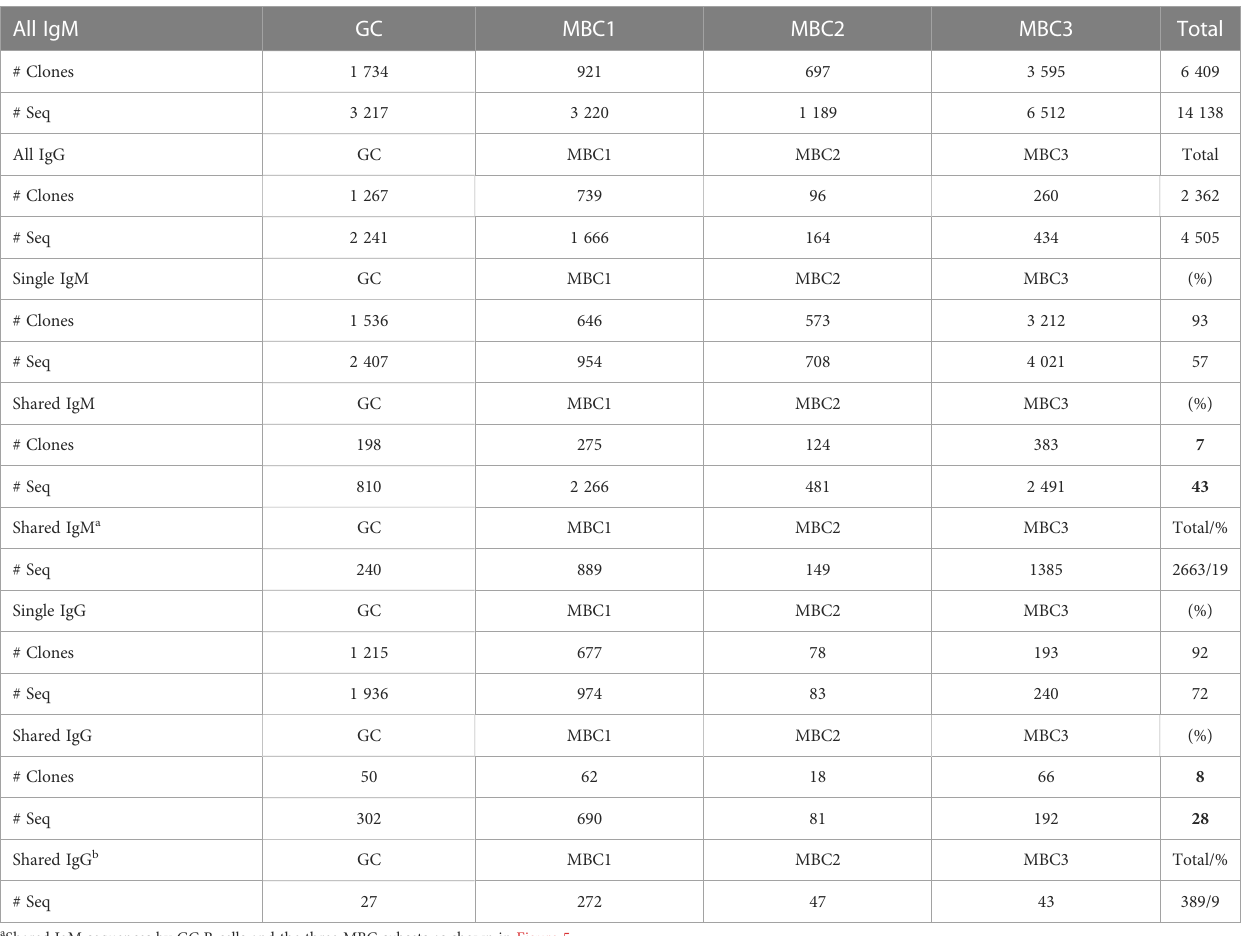
TABLE 1 Summary of unique H-CDR3 clone and